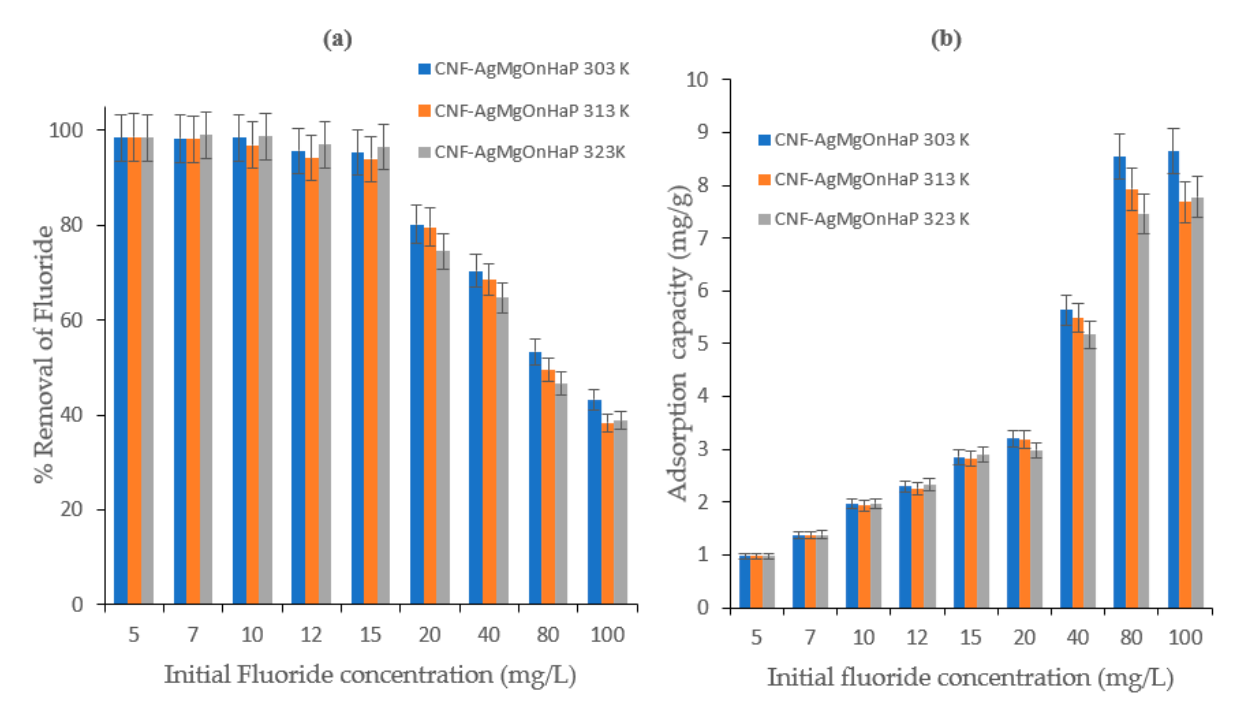
Figure 10. Effect of initial fluoride concentration on CNF-AgMgOnHaP adsorbent at different tem- peratures.